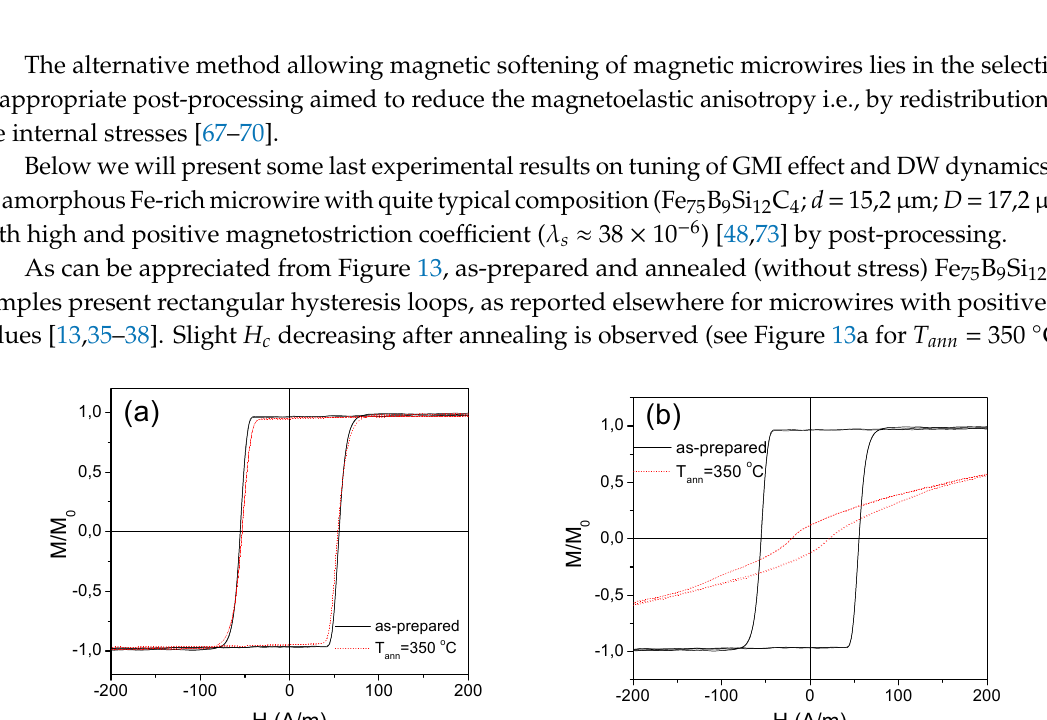
Figure 15. Δ Z/Z ( H ) dependencies observed in as-prepared and stress-annealed at T ann = 350 °C for σ a = 190 MPa Fe 75 B 9 Si 12 C 4 microwires ( f = 200 MHz) ( a ) and the same dependencies measured at 400 and 800 MHz ( b ). The stress-annealed ( T ann = 350 °C for σ a = 190 MPa) Fe 75 B 9 Si 12 C 4 microwire presents rather unusual and irregular Δ Z/Z ( H ) dependence for intermediate frequency range (100–400 MHz) (see Figure 15a,b). However, rising the frequency a double-peak Δ Z/Z ( H ) dependence of stress-annealed Fe 75 B 9 Si 12 C 4 microwire is observed (see Figure 15b). On the other hand, for low frequencies ( f ≤ 50 MHz) the single peak Δ Z/Z ( H ) dependence of stress-annealed Fe 75 B 9 Si 12 C 4 microwire is observed (see Figure 16a). Similar behavior is observed for the Fe 75 B 9 Si 12 C 4 microwires stress-annealed at different conditions: single-peak dependence for low f region, double peak for high enough frequencies and irregular Δ Z/Z ( H ) dependence for intermediate f –values (see Figure 16).